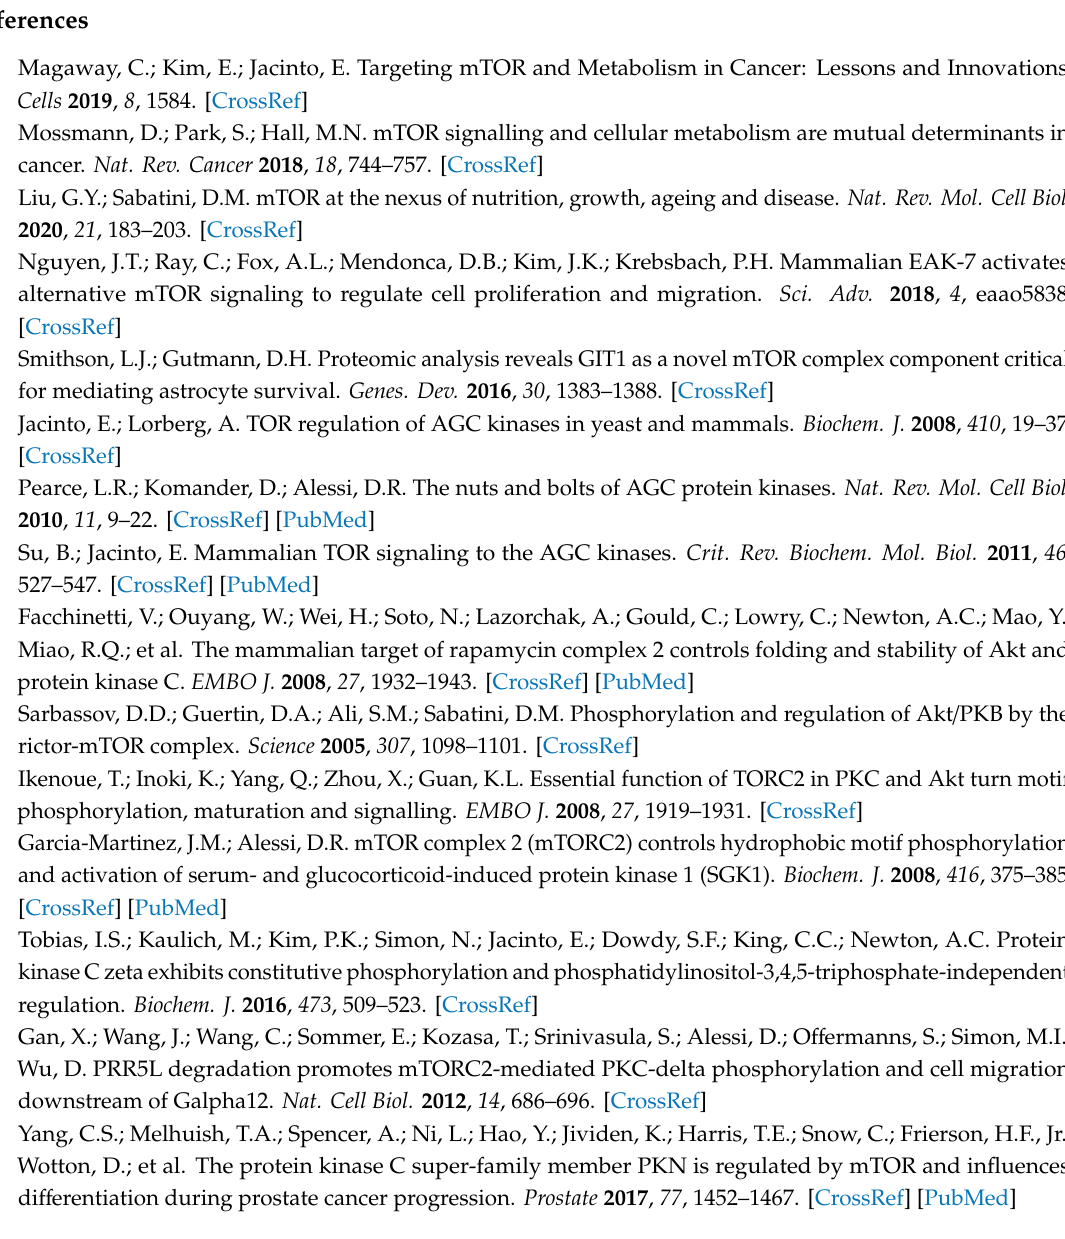
Figure S1: There is increased RSK HM site phosphorylation upon removal of amino acids, Figure S2: RSK HM site phosphorylation is not inhibited by rapamycin, Figure S3: RSK-Ser381Ala mutant is not phosphorylated during serum restimulation, Figure S4: RSK-WT colocalizes with SIN1 at the membrane during early nutrient withdrawal, Figure S5: There is increased association of RSK and SIN1 during glucose / glutamine